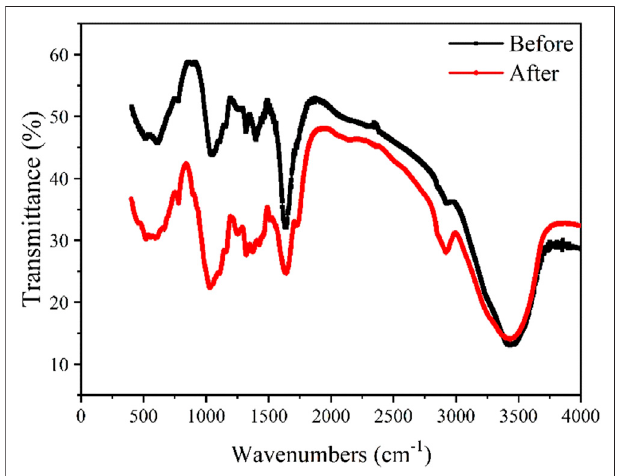
FIGURE 4 | FTIR patterns of EFR before and after reaction with Pb(II)